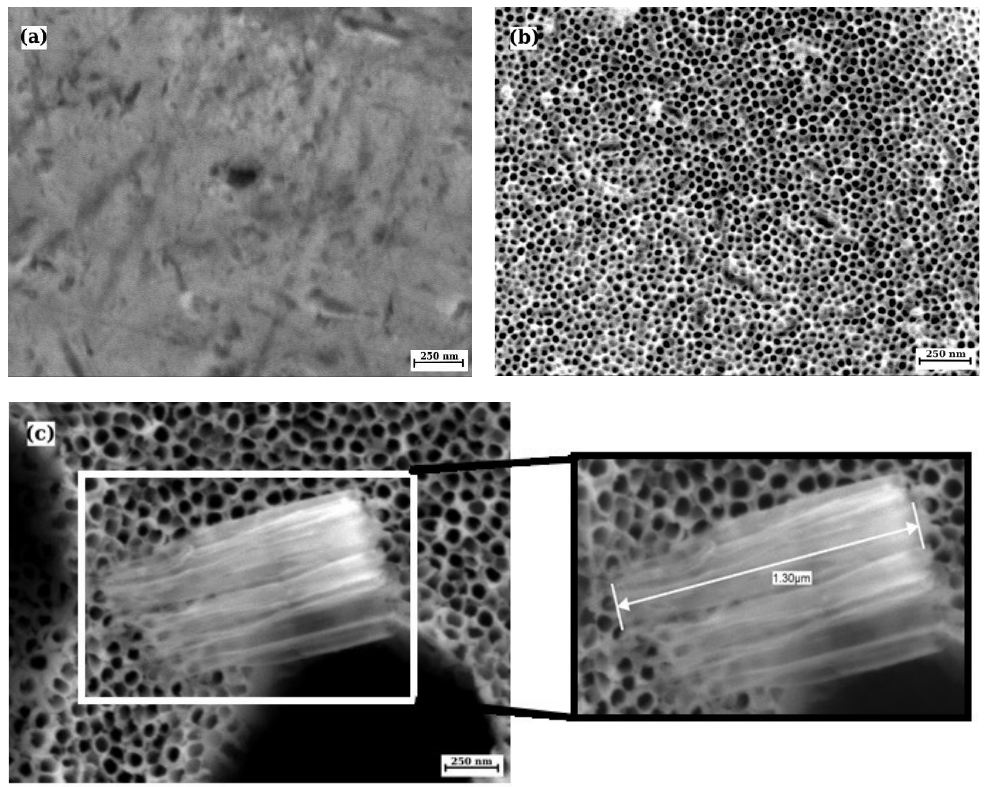
Figure 3. SEM images of the untreated surface of Ti-6Al-4V ( a ) and the surface of Ti-6Al-4V anodized for 60 min ( b , c ).